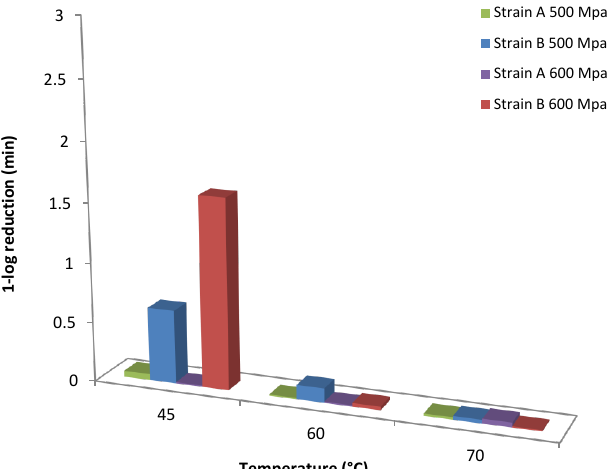
Figure 4. Model based comparison of 1 log reduction (1D value) time of the spores of A. acidoterrestris strains A and B when treated with high pressure levels of 500 s and 600 MPa at 45, 60 and 70 °C.